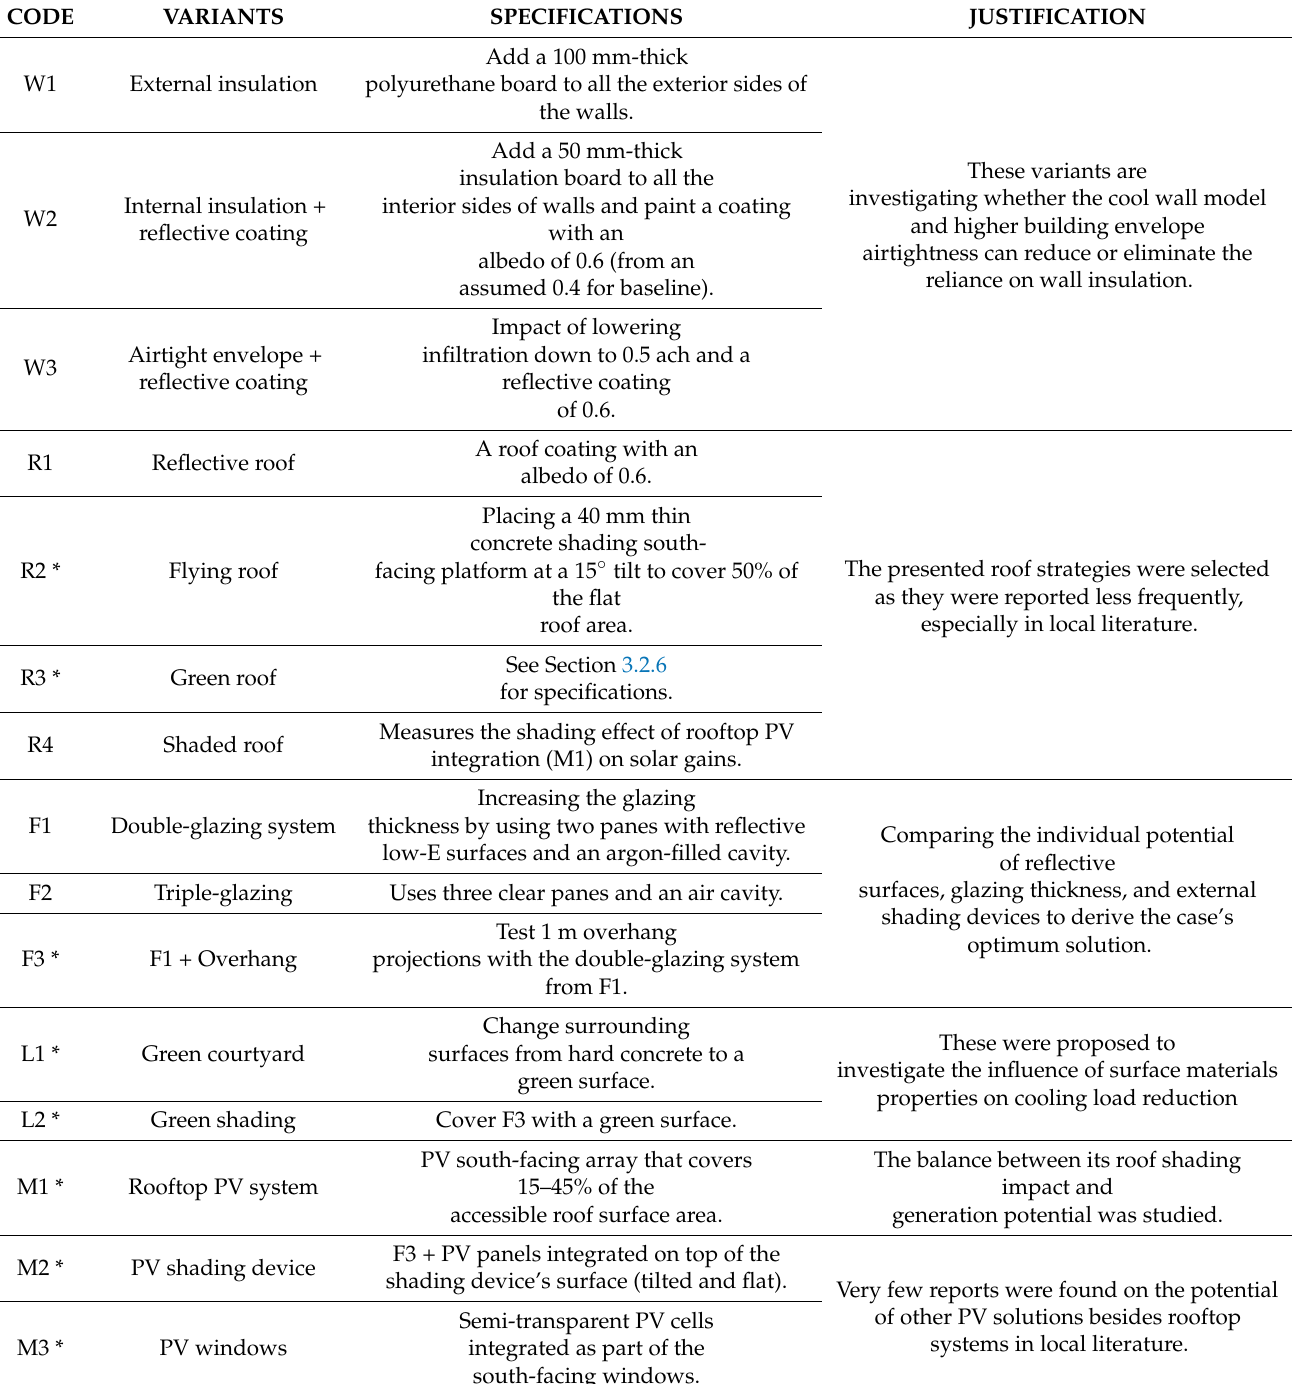
Table 6. Selected strategies for simulation